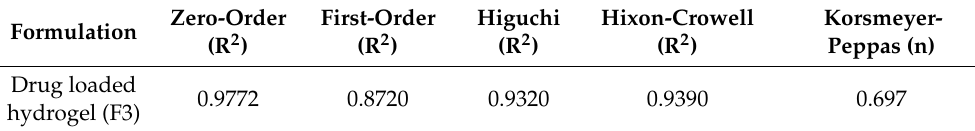
Table 3. Drug release kinetics of drug-loaded hydrogel.